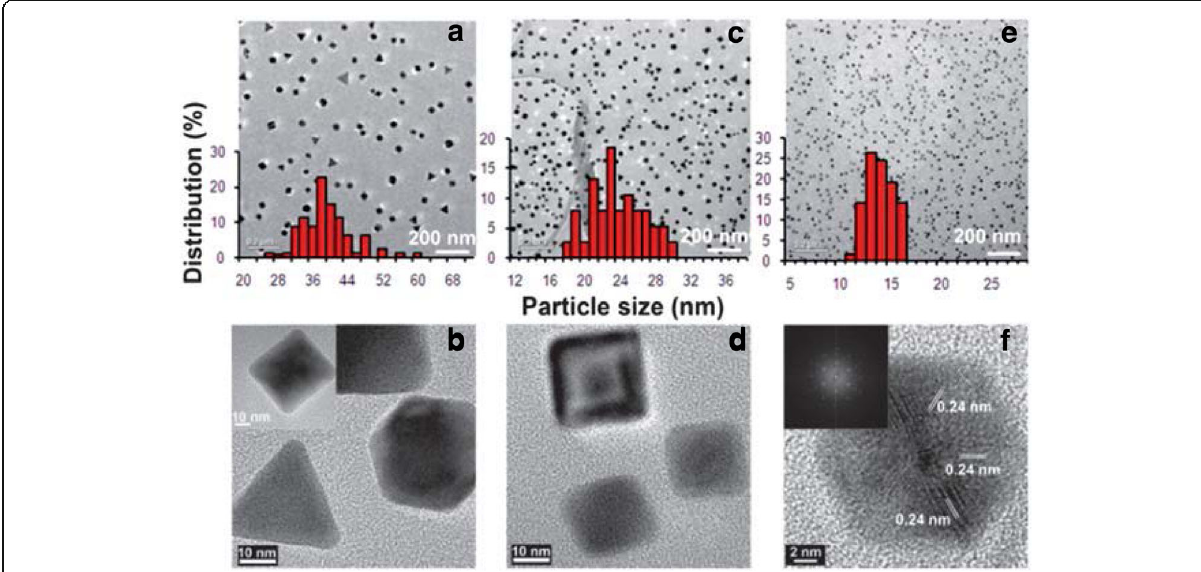
Fig. 3 TEM images and histograms of AuNPs from AuNPs – PVP nanocomposite films with weight ratios of HAuCl4 to PVP, [HAuCl 4 /PVP] = 1:1.5